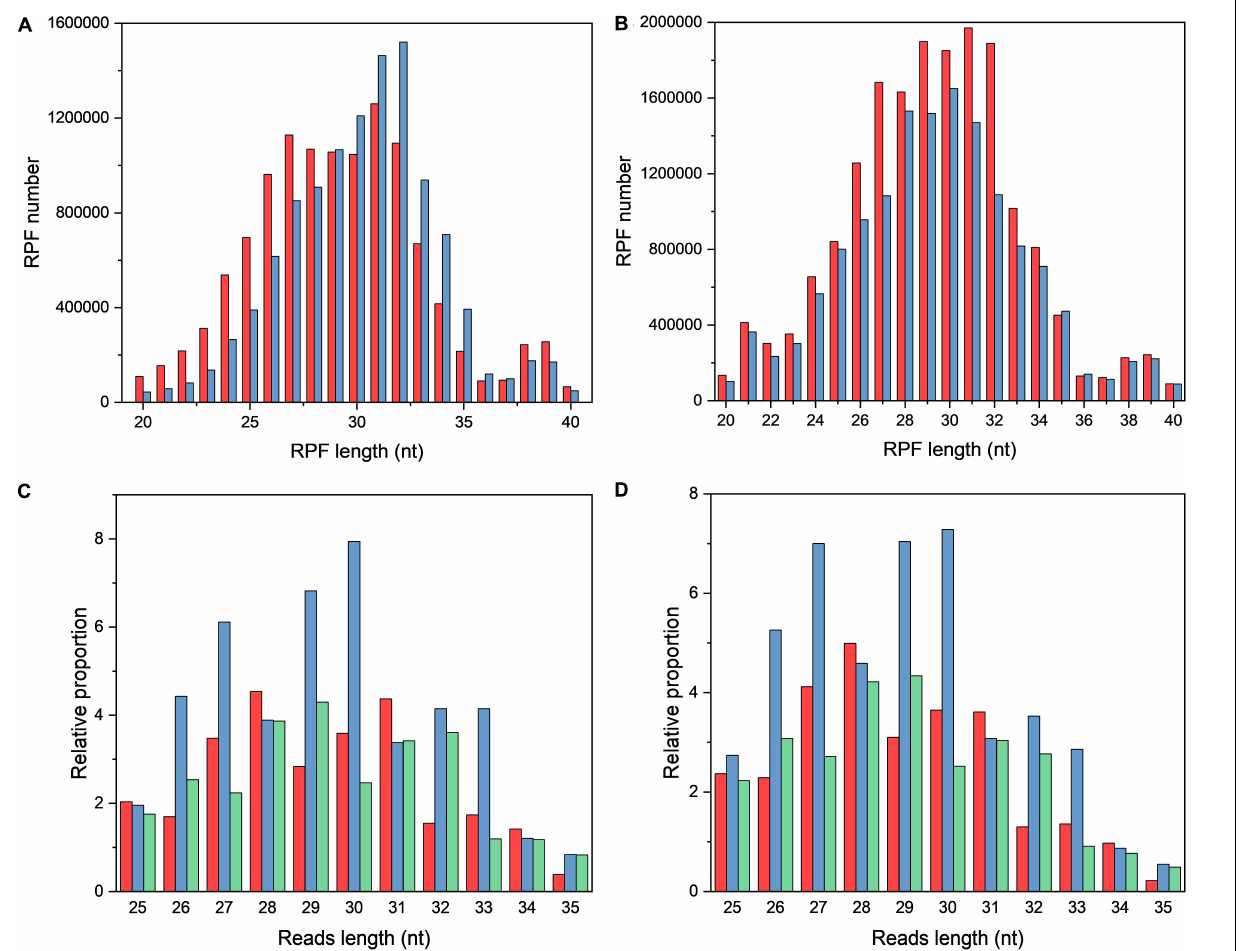
FIGURE 1 | The characteristics of ribosome profiling data in OS and CG. (A,B) Length distribution of RPFs in OS (A) and CG (B) . The red and blue bars refer to two biological replicates. (C,D) Three-nucleotide periodicity at the first 35 nt of CDS in OS (C) and CG (D)